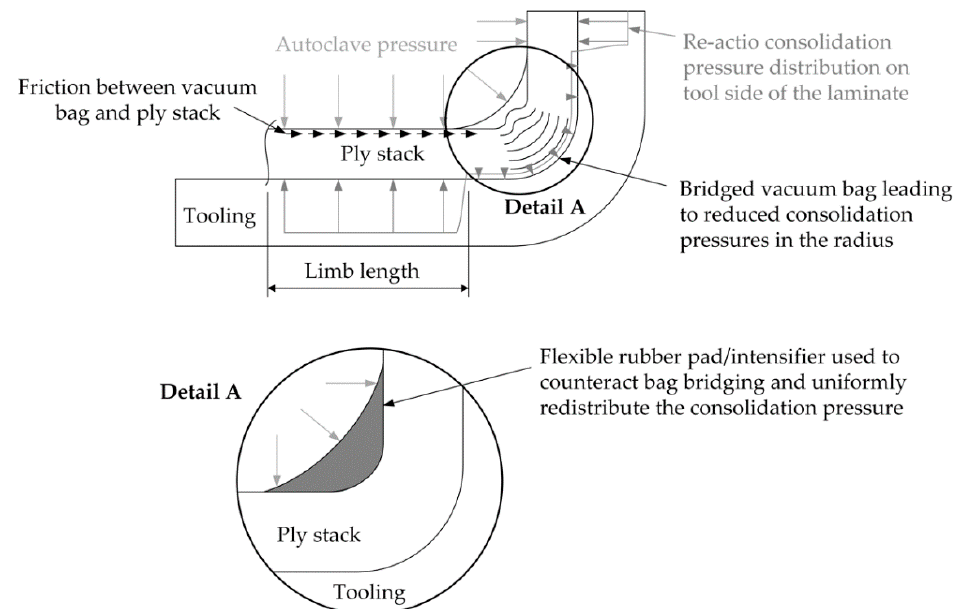
Figure 16. Vacuum bag bridging leading to low compaction pressure in the corner area, fiber waviness, and increased void growth.